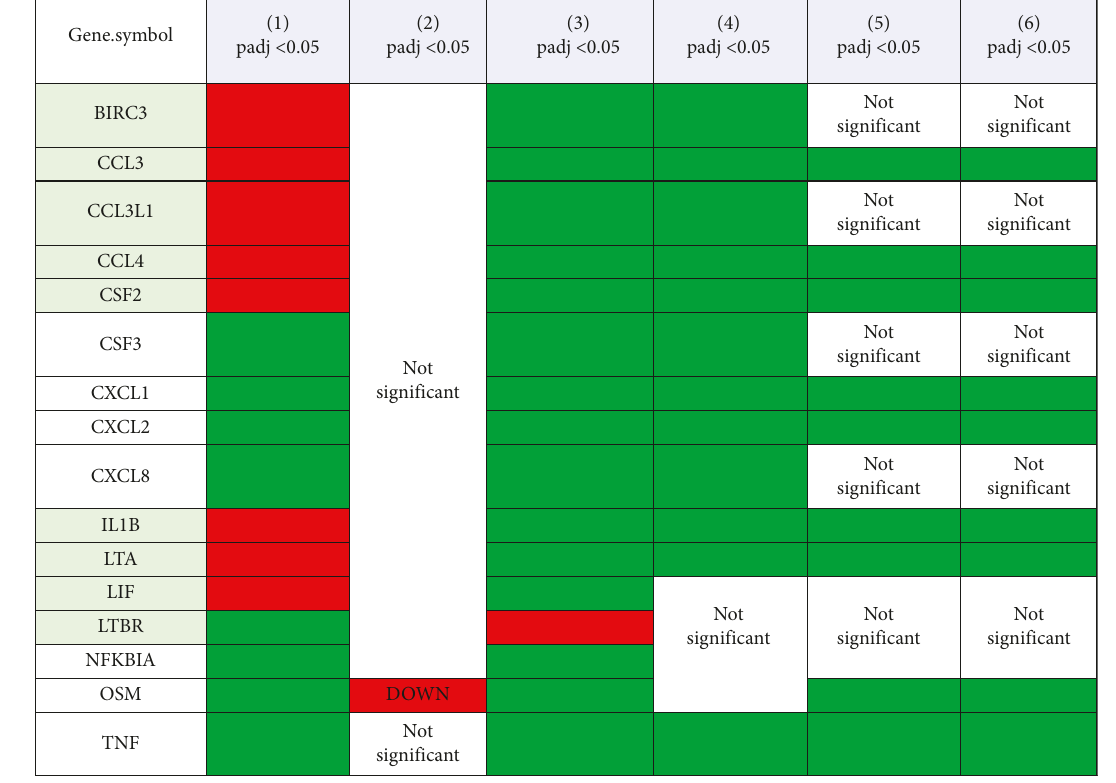
Table 1: Gene expression in PBMCs severe COVID-19 patients with PBMCs subject to BCG stimulation of PBMCs. Data that experienced upregulation were marked with green, downregulation with red, and not significant were marked with white lines.